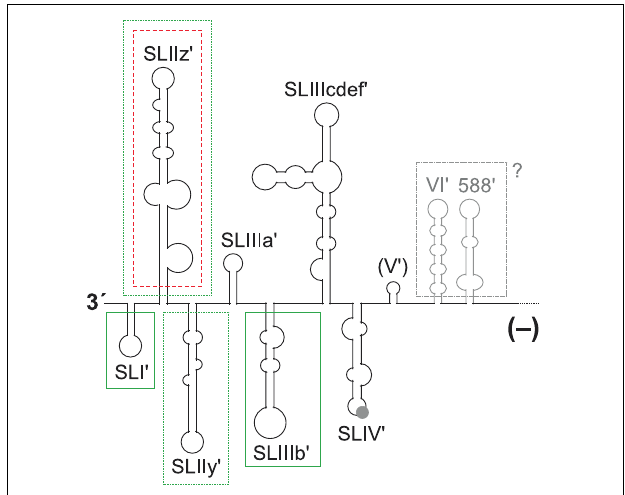
FIGURE 5 | Elements in the 3 (cid:48) region of the HCV minus strand antigenome involved in plus strand synthesis. The black and gray lines and structures show the 3 (cid:48) region of the HCV minus strand antigenome. A contribution to plus strand initiation shown by in vitro -assays is indicated by boxes with solid green lines (SL I (cid:48) , SL IIIb (cid:48) ), a negative influence indicated by these in vitro -assays is indicated by a box with a red broken line (SL IIz (cid:48) ). Sequences that were characterized by replicon studies to have a positive influence on RNA replication are boxed with dotted green lines (SL IIz (cid:48) and SL IIy (cid:48) ). The region which is not boxed is variable in RNA secondary structure among the predictions (see text), and no study showed a functional contribution of this region to replication. A possible relevance of the upstream structures SL VI (cid:48) and 588 (cid:48) as present in the minus strand is not clear.